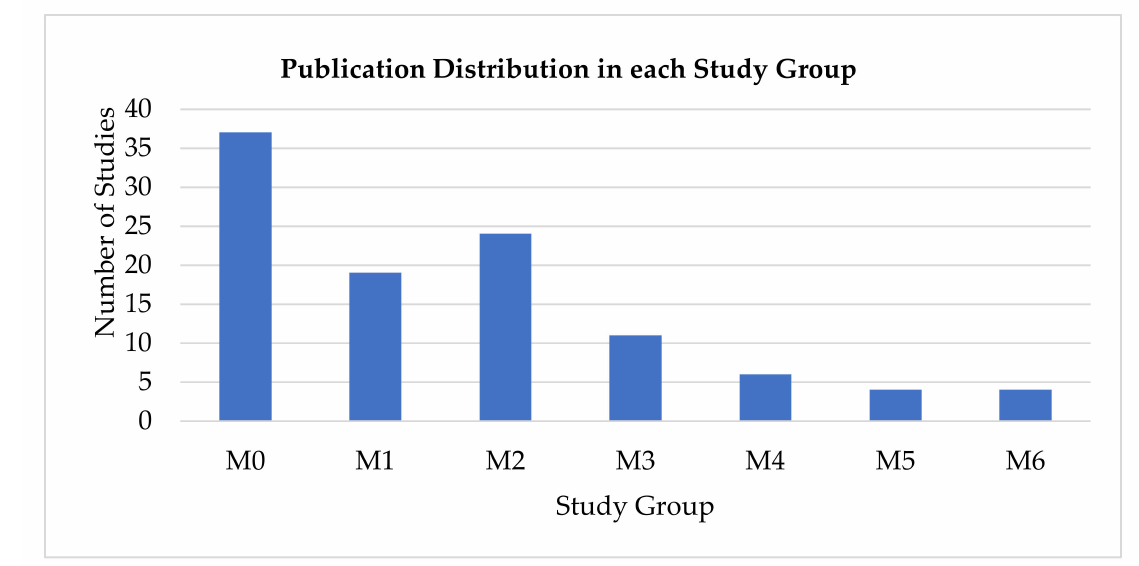
Figure 3. Publication distribution for the study groups.